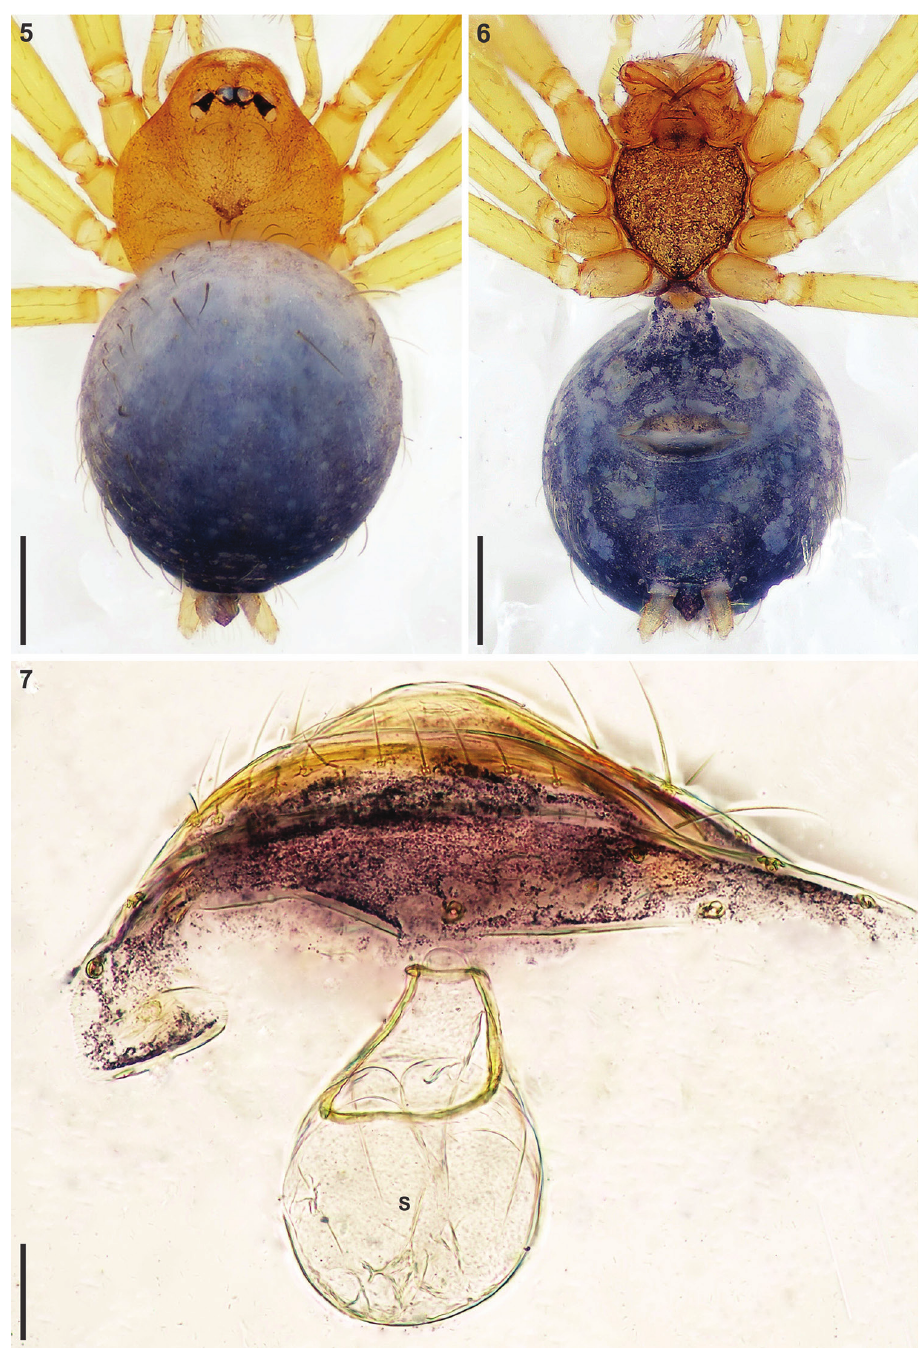
Figures 5–7. Cangoderces globosa sp. n., female holotype. 5 habitus, dorsal view 6 habitus, ventral view 7 genitalia, dorsal view. Abbreviation: S – spermatheca. Scale bars: 0.25 mm ( 5, 6 ); 0.05 mm ( 7